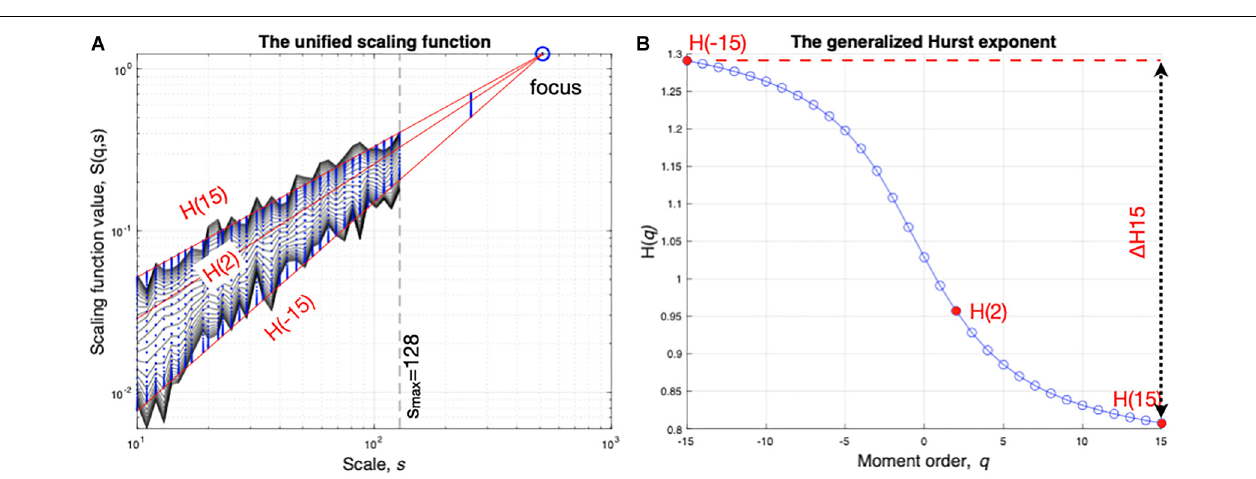
FIGURE 3 | End-point parameters obtained with multifractal analysis of experimental time series (cycling as an example). The scaling function (A) is acquired by multifractal DFA. In that, standard deviation is calculated as a function of scale and the process is repeated along several statistical moments q . The generalized ( q -dependent) Hurst exponent (B) is acquired via linear regression with the focus used as a reference point. Global scale-invariance (monofractal) is described by H(2), while the degree of multifractality is captured as the difference between H( q ) calculated at the minimal ( − 15) and maximal (15) q